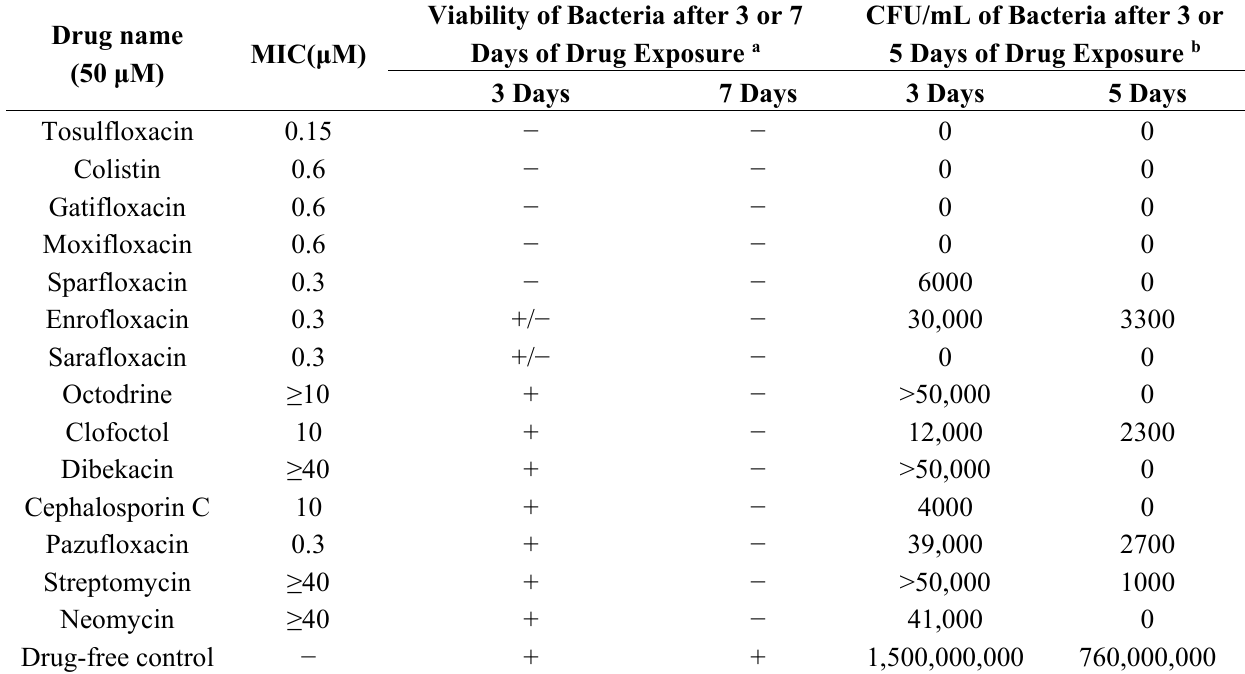
Table 1. Activity of 14 drug candidates from the clinical drug library that are active against stationary phase E. coli UTI89 persisters.